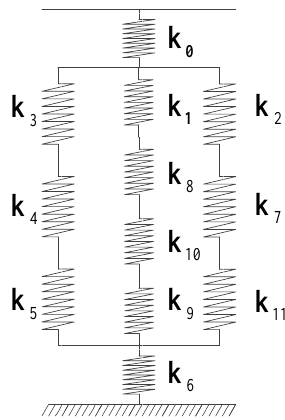
Figure 3. The static spring equivalent model of the piezoelectric six-axis force